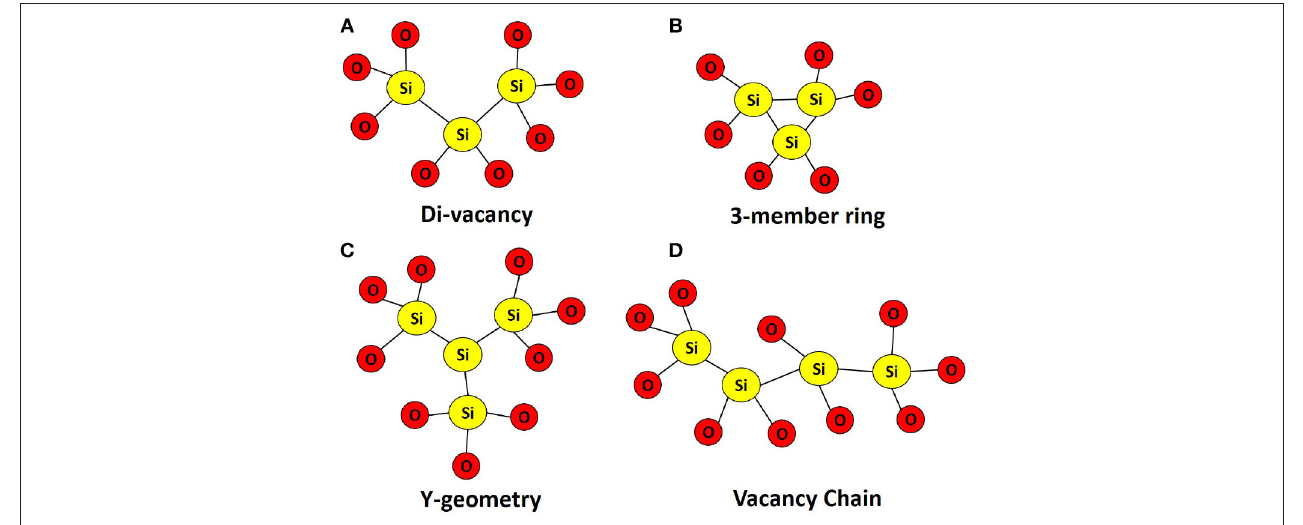
FIGURE 1 | Typical geometries of (A) Oxygen di-vacancy in a-SiO 2 , (B–D) Oxygen tri-vacancies in a-SiO 2 . Oxygen tri-vacancies can occur in one of three configurations: a 3-member Ring; a “Y-geometry”; and as a vacancy chain.